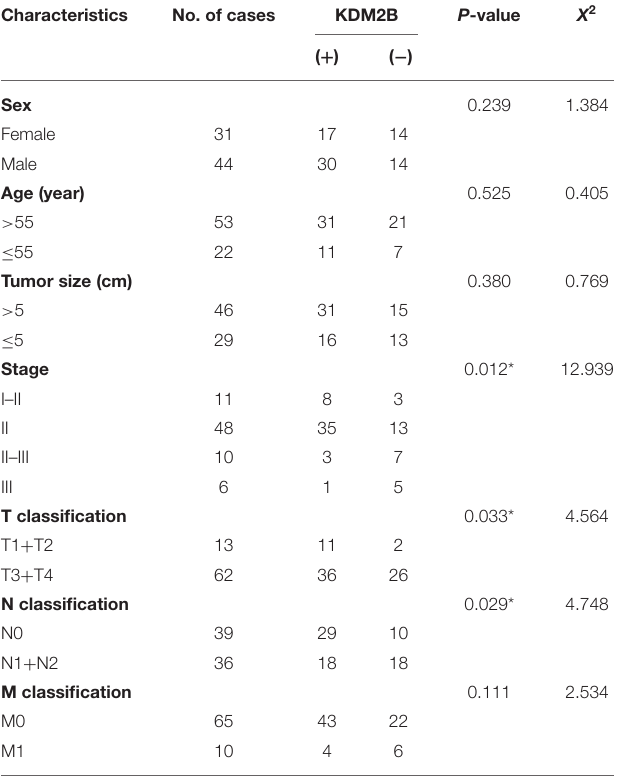
TABLE 2 | Relationship between KDM2B expression and clinicopathologic parameters in colorectal cancer.